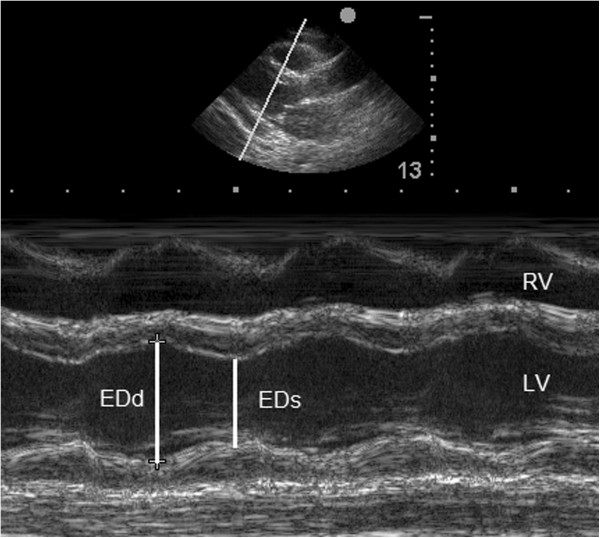
Measurement of the ejection fraction using M-mode in the parasternal long-axis view. The LV end-diastolic internal dimensional (EDd) is measured at the largest dimension, and the LV end-systolic internal dimensional (ESd) is measured at the smallest dimension. RV, right ventricle.